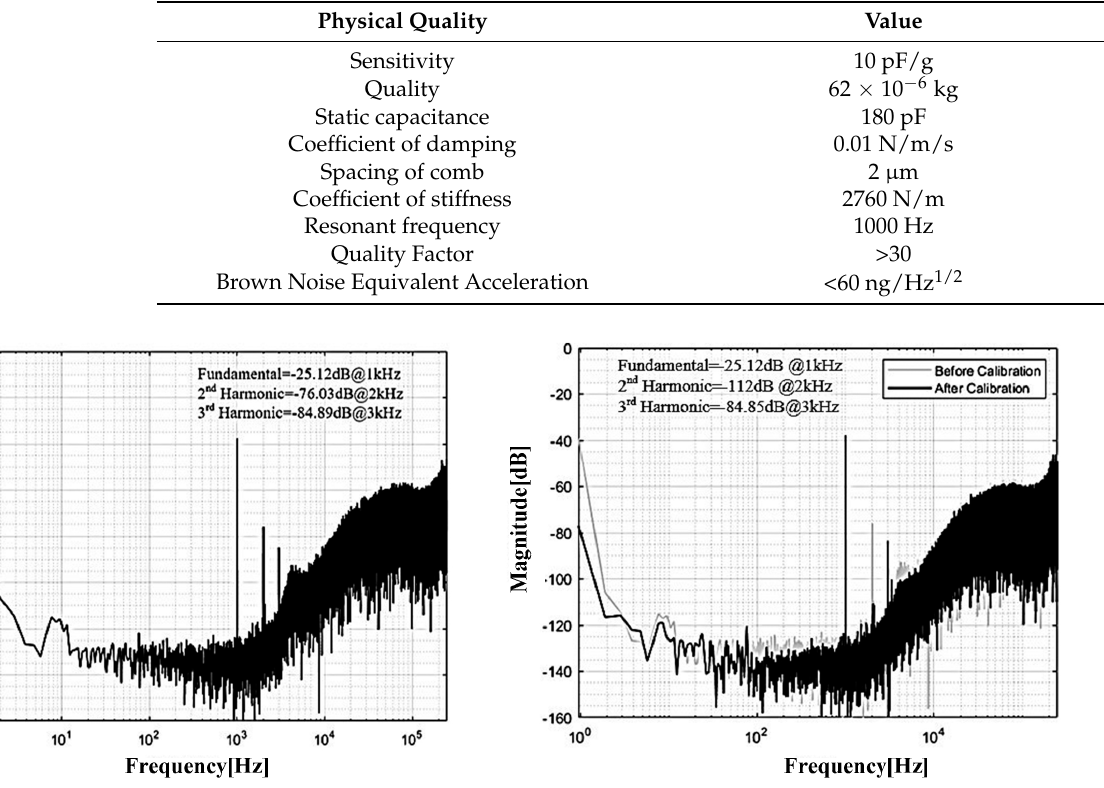
Figure 7. The power spectrum density diagram of the output bitstream. Table 1. Properties summary and comparison.